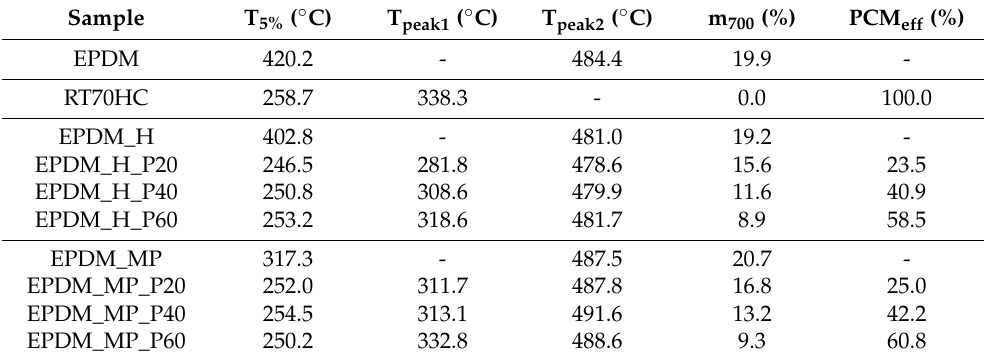
Table 6. Results of the TGA tests on bulk EPDM sample, neat paraffin (RT70HC), and the prepared